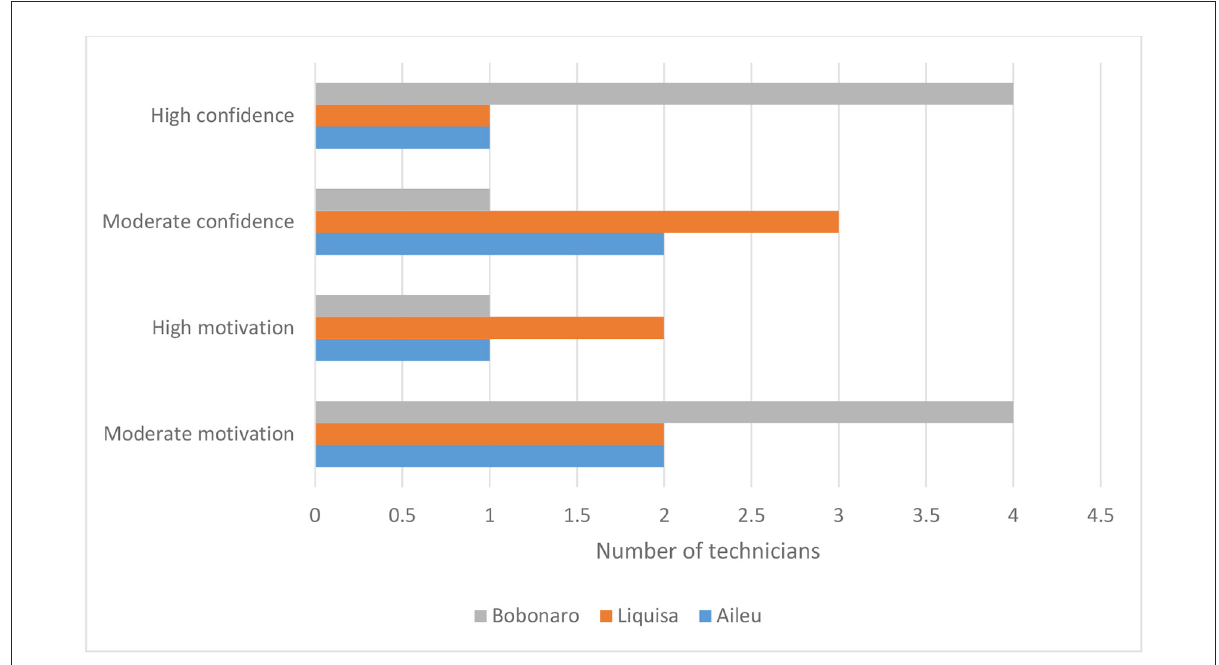
FIGURE4 Self-reported change in technician motivation and confidence to work with farmers ( N =